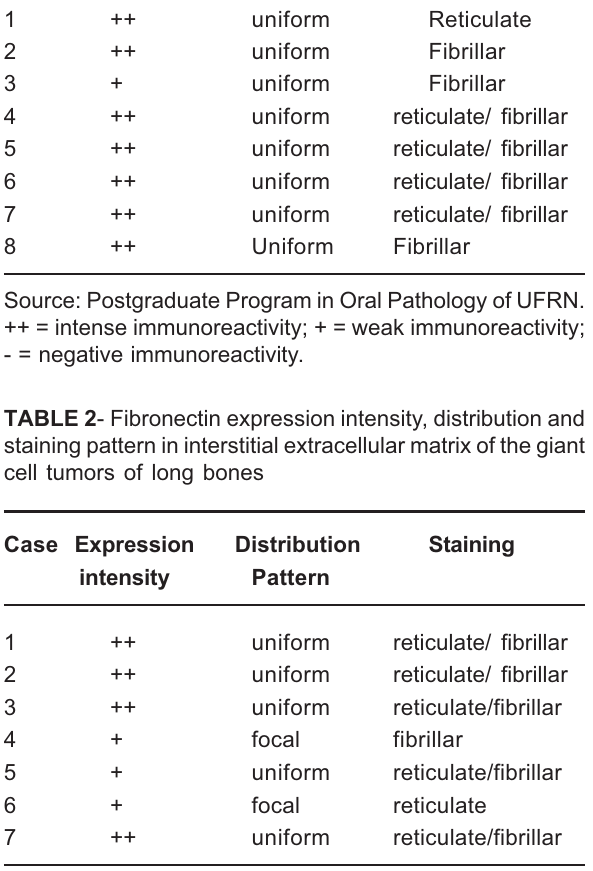
Source: Pathology and Cytology Laboratory, Aracaju, SE, Brazil. ++ = intense immunoreactivity; + = weak immunoreactivity; - = negative immunoreactivity.